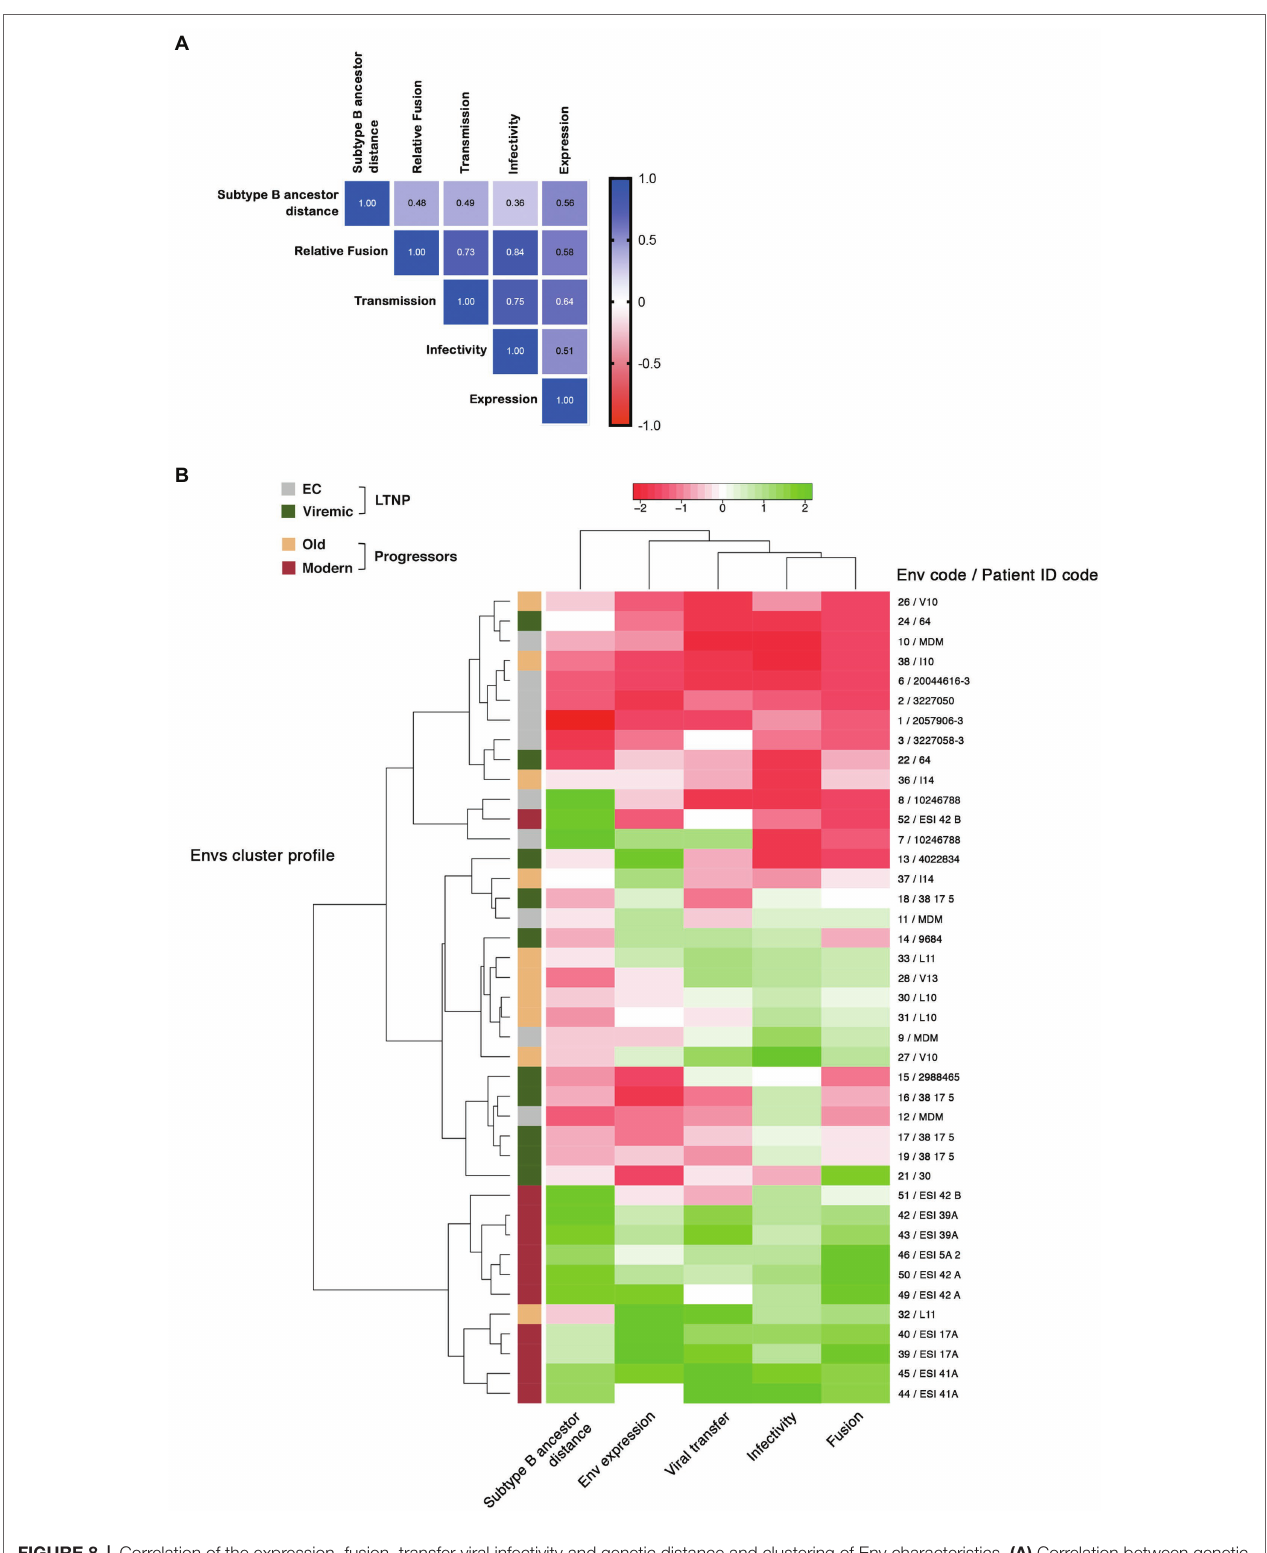
FIGURE 8 | Correlation of the expression, fusion, transfer viral infectivity and genetic distance and clustering of Env characteristics. (A) Correlation between genetic distance to subtype B ancestor of Envs of all different groups and Env expression, relative fusion, HIV Transfer, and Infectivity (Spearman correlation values are indicated in the matrix representation). (B) Env from LTNP-ECs ( gray ), vLTNPs ( green ), Old patients ( orange ), and Modern patients ( red ) were analyzed according to the indicated parameters. Two main clusters corresponding to EC and modern progressors were identified with opposite functional